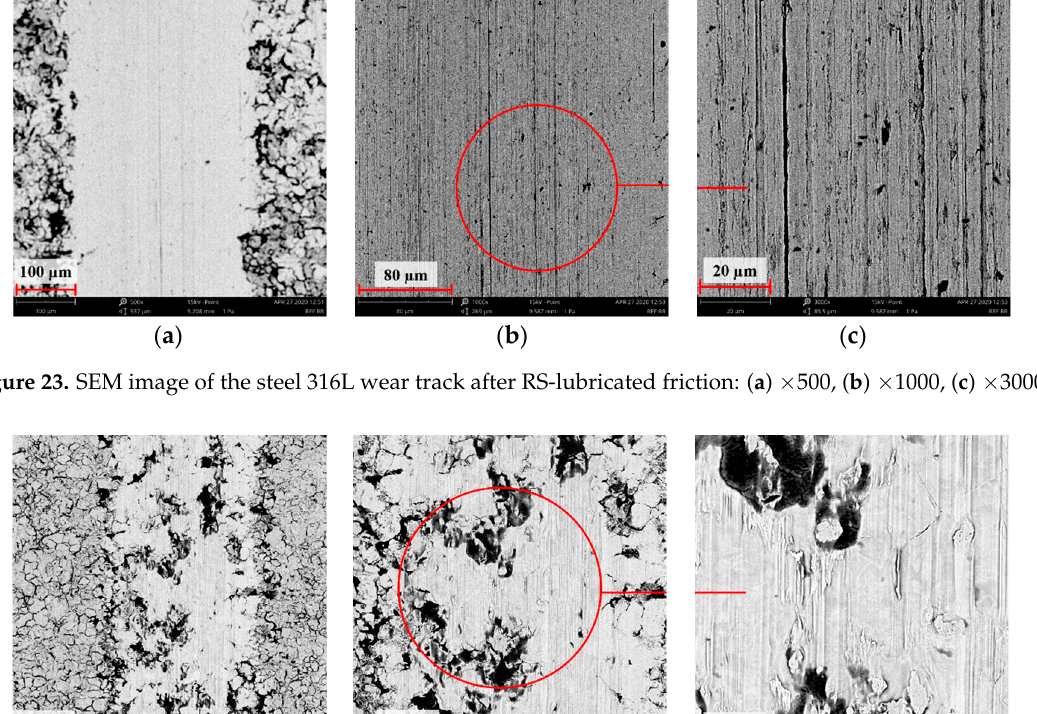
Figure 22. SEM image of the oxygen ion-implanted steel 316L wear track after dry sliding: ( a ) ×500, ( b ) ×1000, ( c ) ×3000.